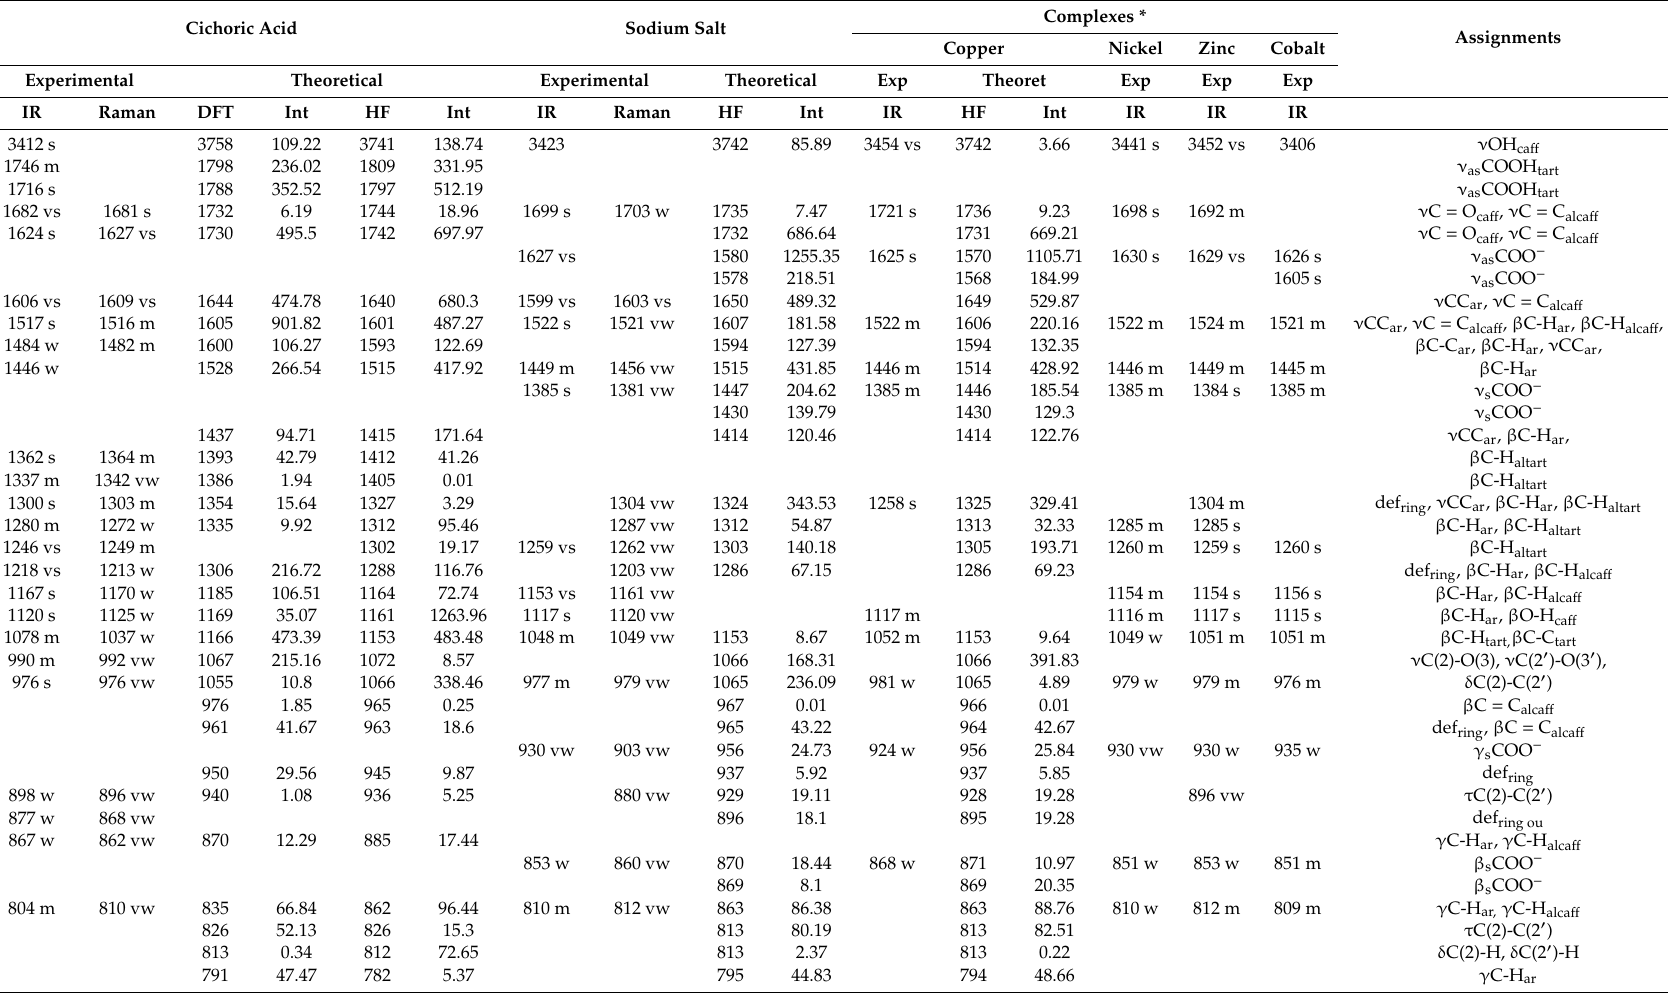
Complexes * Assignments Copper Cobalt